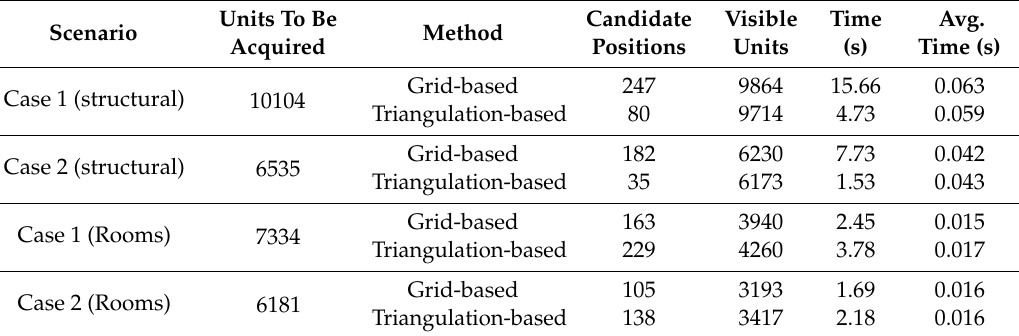
Table 4. Results of visibility analysis.